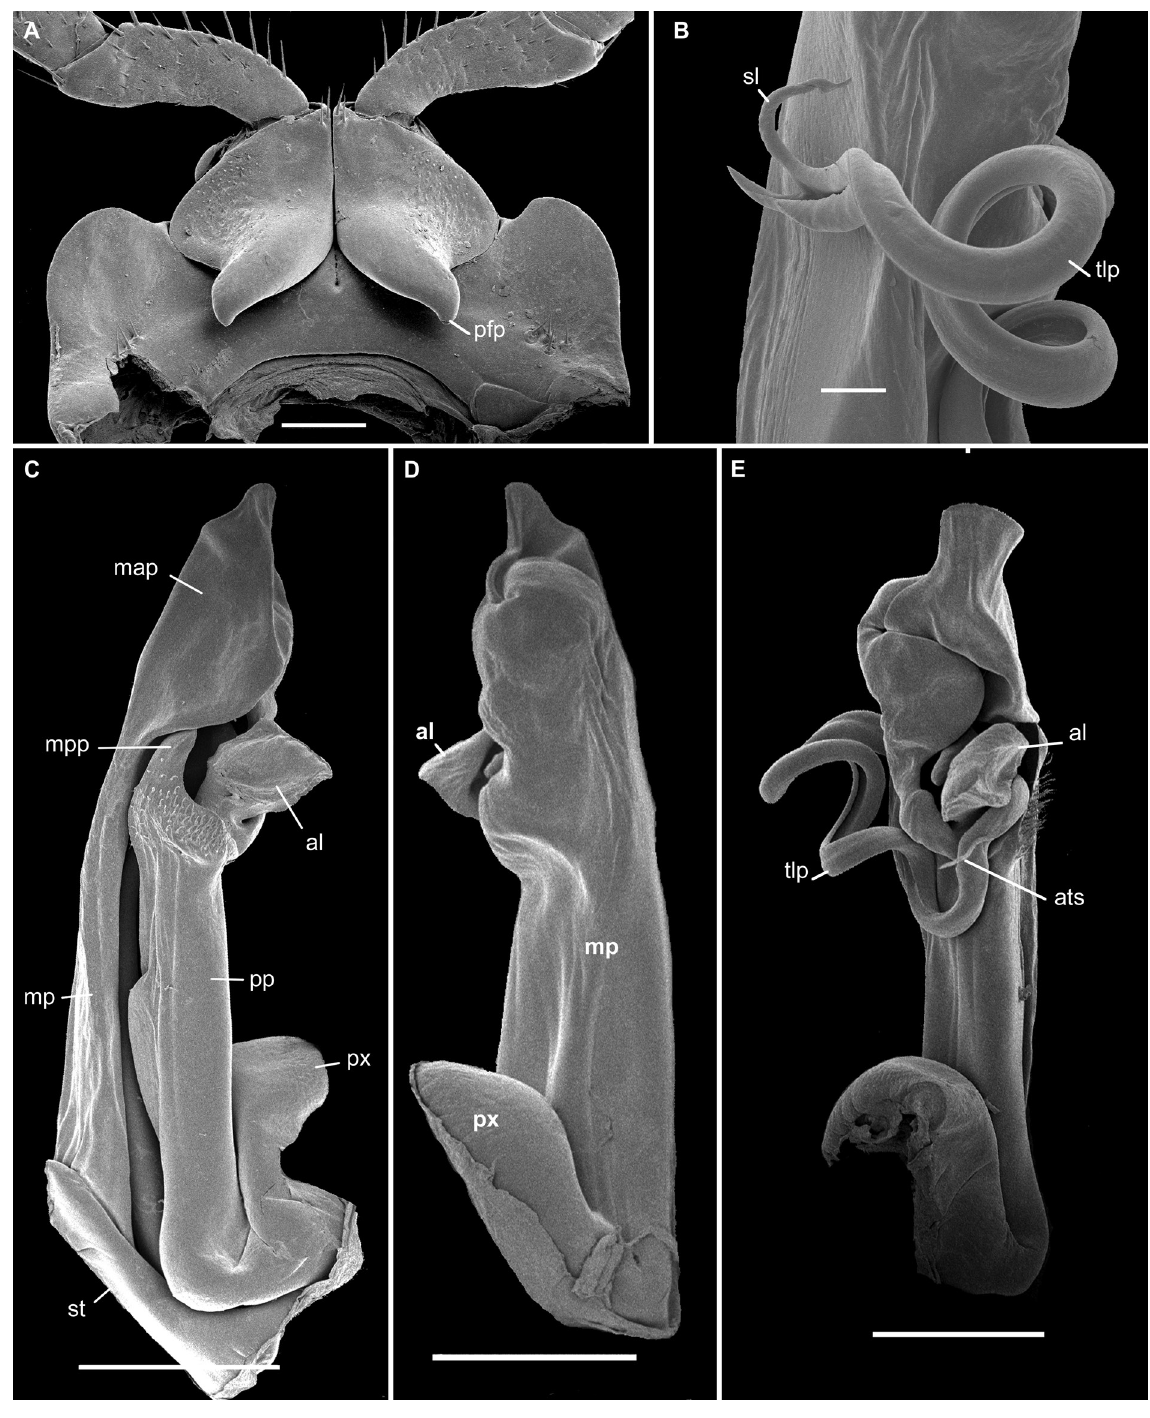
Fig. 5. Sechelleptus arborivagus sp. nov., paratype, ♂ (BE_RMCA_MYR.Dip.22875). SEM views. A . First pair of legs, frontal view. B . Apical part of gonopod telopodite. C . Gonocoxite, oral view. D . Gonocoxite, caudal view. E . Gonopod, lateral view. Abbreviations: al = apicolateral lamellose lobe; ats = antetorsal process; mp = metaplica; mpp = mesaplical projection; pfp = prefemoral process; pp = proplica; px = paracoxite; sl = solenomere; st = sternite; tlp = telopodite. Scale bars: A = 500 µm; B = 100 µm; C–E = 1